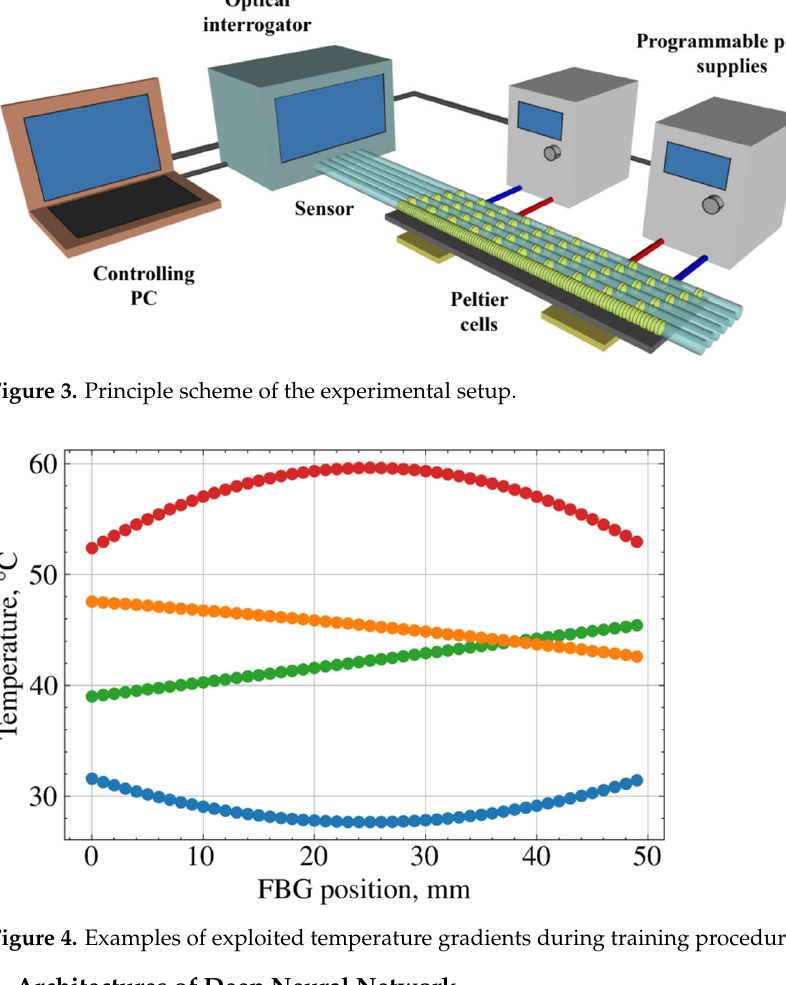
Figure 3. Principle scheme of the experimental setup.